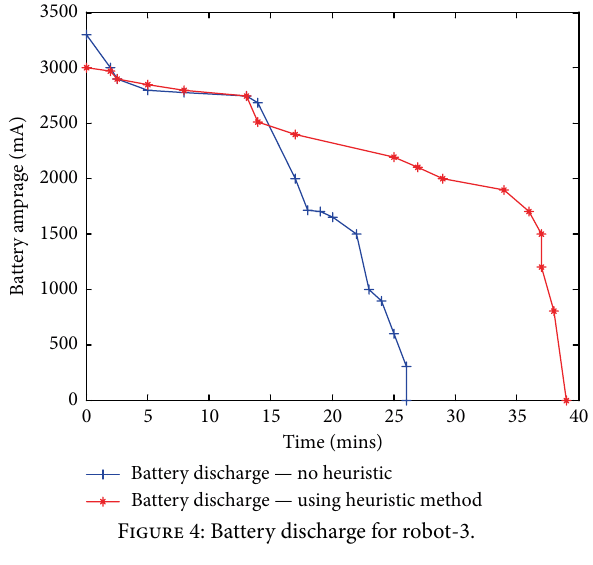
Figure 4: Battery discharge for robot-3.